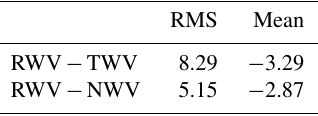
Table 4. Statistical results from Eq. (11)-derived and radiosonde- derived PWV (gm − 3 ). RWV is the water vapor density obtained from the radiosonde product; TWV is the water vapor density derived from the H we obtained by the traditional method using Eq. (11); NWV is the water vapor density derived from the H we obtained by the new method using Eq.